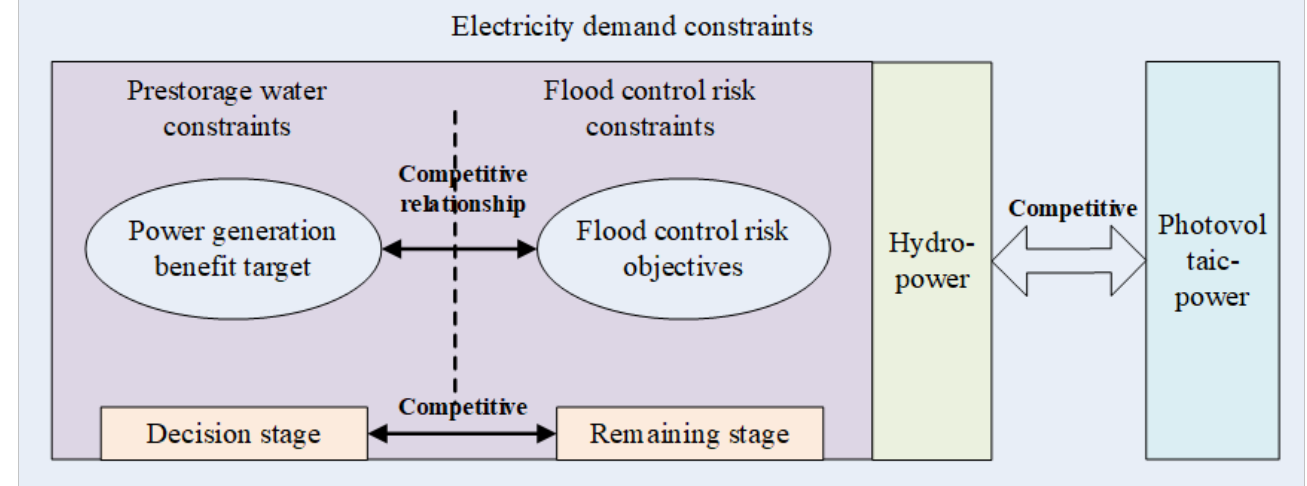
Figure 2. Multi-objective conflict of hydropower and photovoltaic joint dispatching.